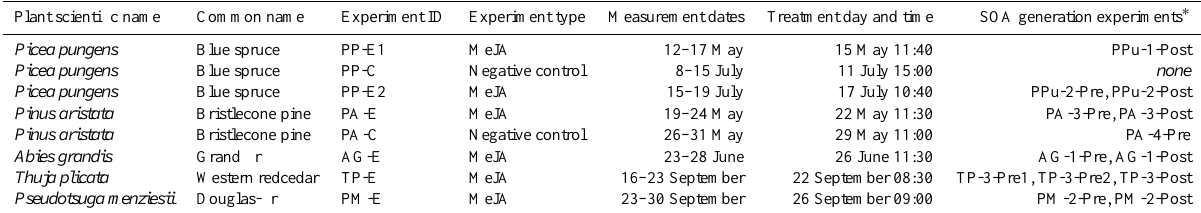
Table 1. Experiment